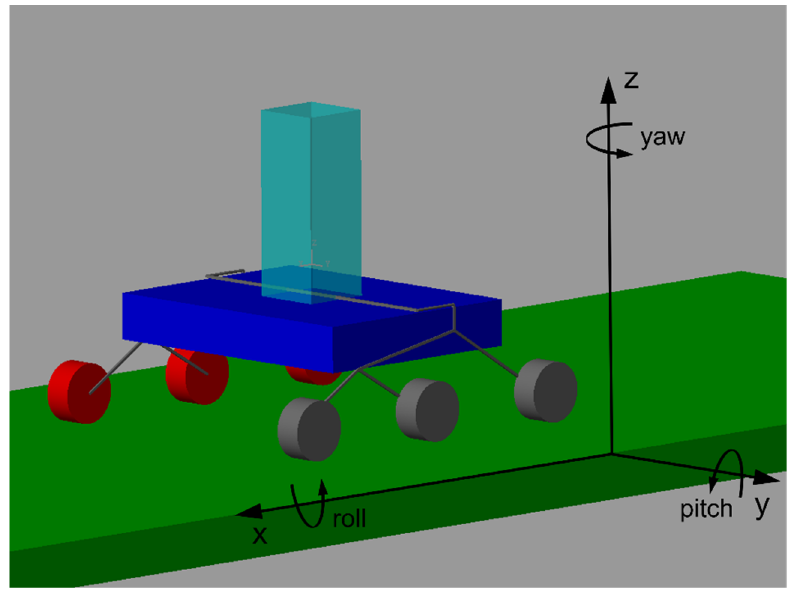
Figure 6. Multibody simulation of the rover in static conditions for the rollover study. Roll and pitch angle variations were considered for this first test.